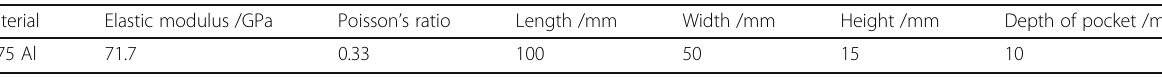
Table. 1 Basic information of the part